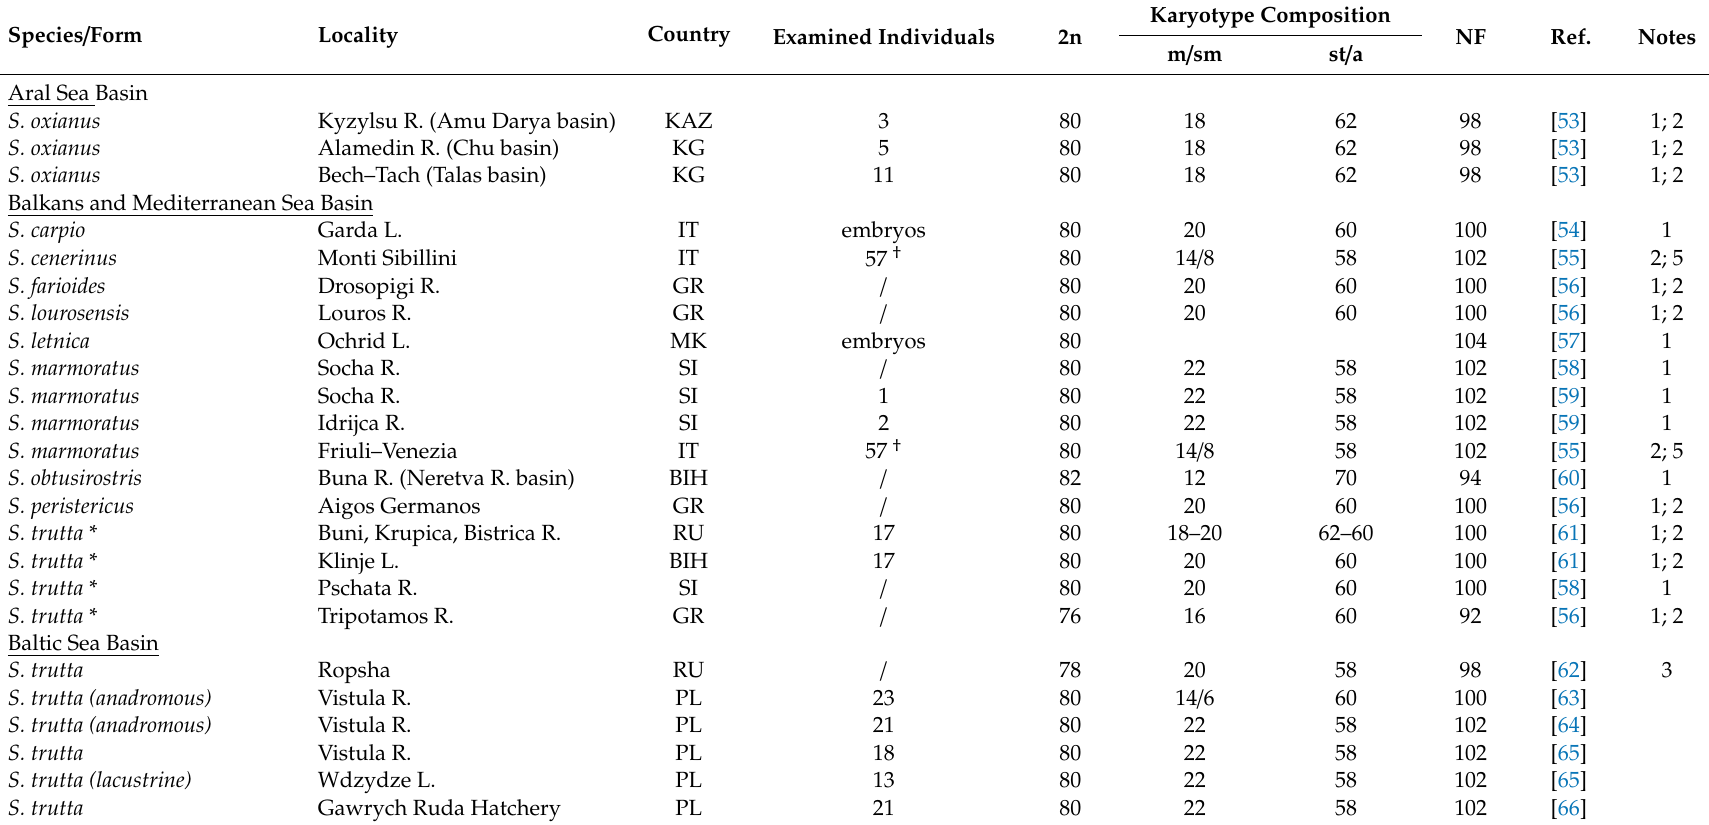
Table 1. Review of reported cytogenetic data for members of Palearctic trout of the genus Salmo. Species /